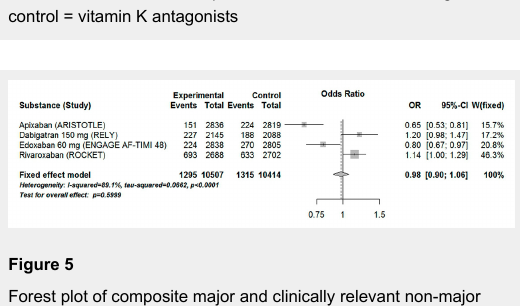
Forest plot of composite major and clinically relevant non-major bleeding in patients with atrial fibrillation aged 75 years or over for analysis including high-dose dabigatran and edoxaban. CI = confidence interval; experimental = direct oral anticoagulants; control = vitamin K